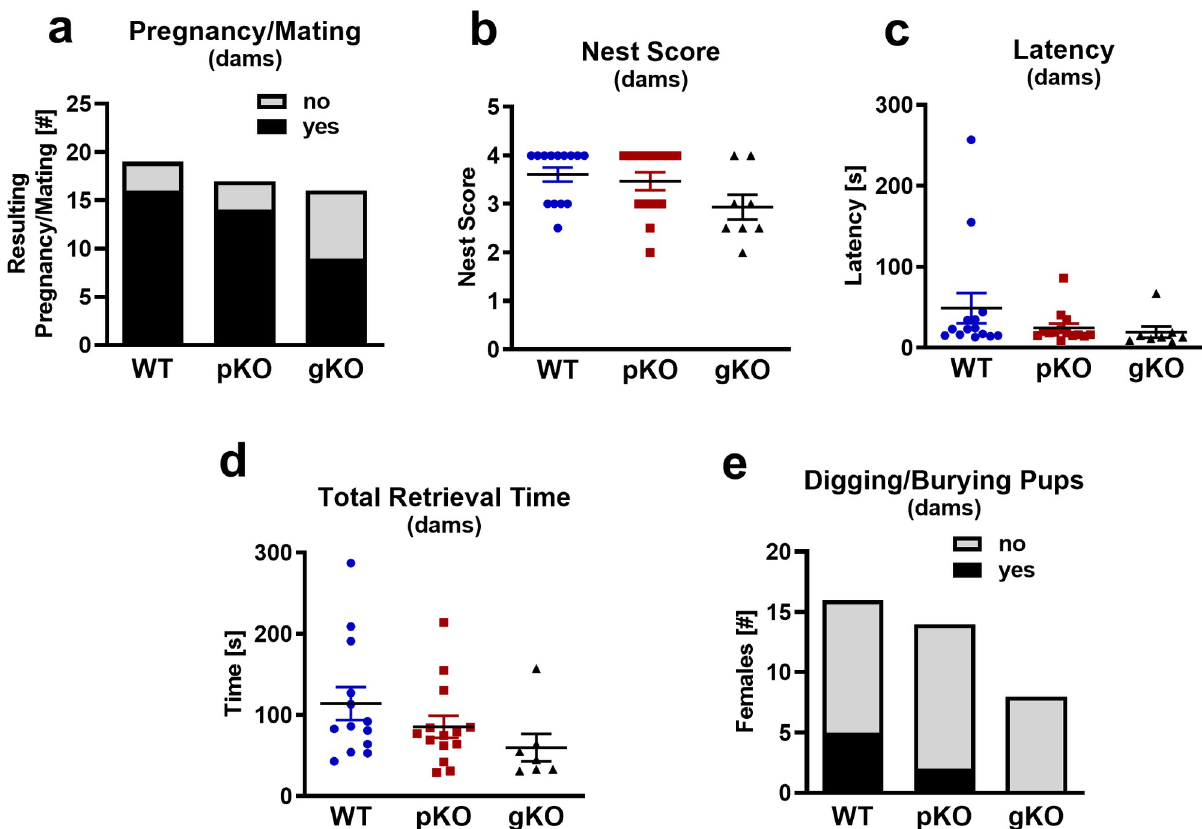
Fig 4. Maternal behavior testing in primiparous female mice. Conception rate (a), nest building (b), latency, time to retrieve the first pup (c), total pup retrieval time (d) and pup digging/burying behavior (e) did not differ in wild-type, Mest pKO and Mest gKO primiparous mice. Data were analyzed either by Chi-square (a, e) or multiple one-way ANOVA (b, c, d). No significant differences were observed between